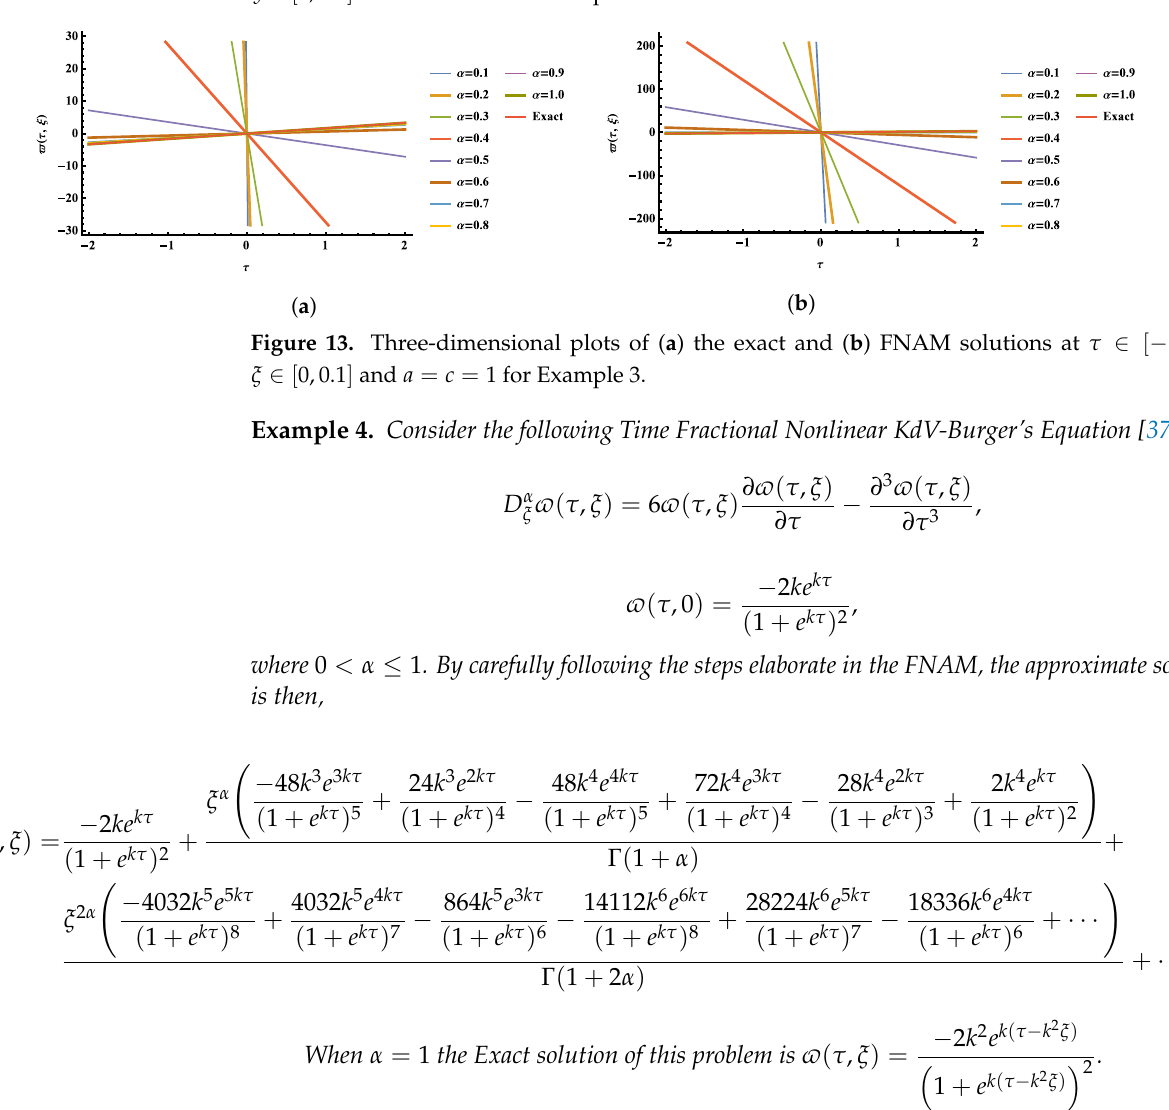
Figure 12. Three-dimensional plots of ( a ) the exact and ( b ) FNAM solutions at τ ∈ [ − 10,10 ] , ξ ∈ [ 0,0.1 ] and a = c = 1 for Example 3.